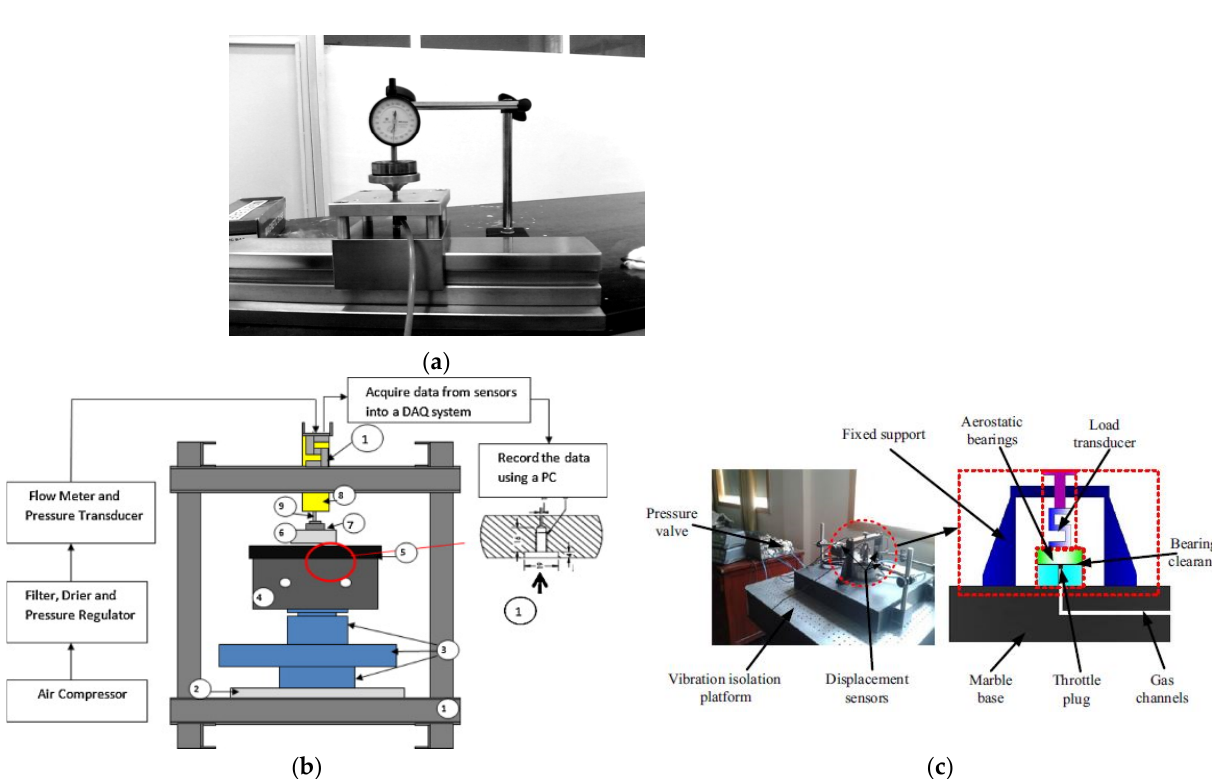
Figure 6. Measurement of loading capacity and gas film of bearing. ( a ) the test table [38]. ( b ) experiment setup [39]. ( c ) Experimental setup for measuring the stiffness and stability [40].